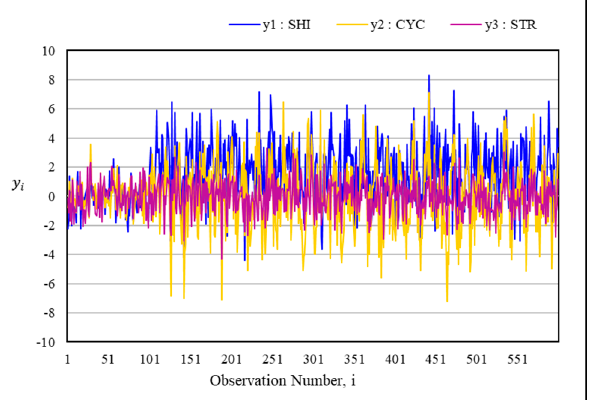
Figure 2. Three MIMO process outputs, which concurrently contain single SHI, CYC and STR disturbances after time 100.